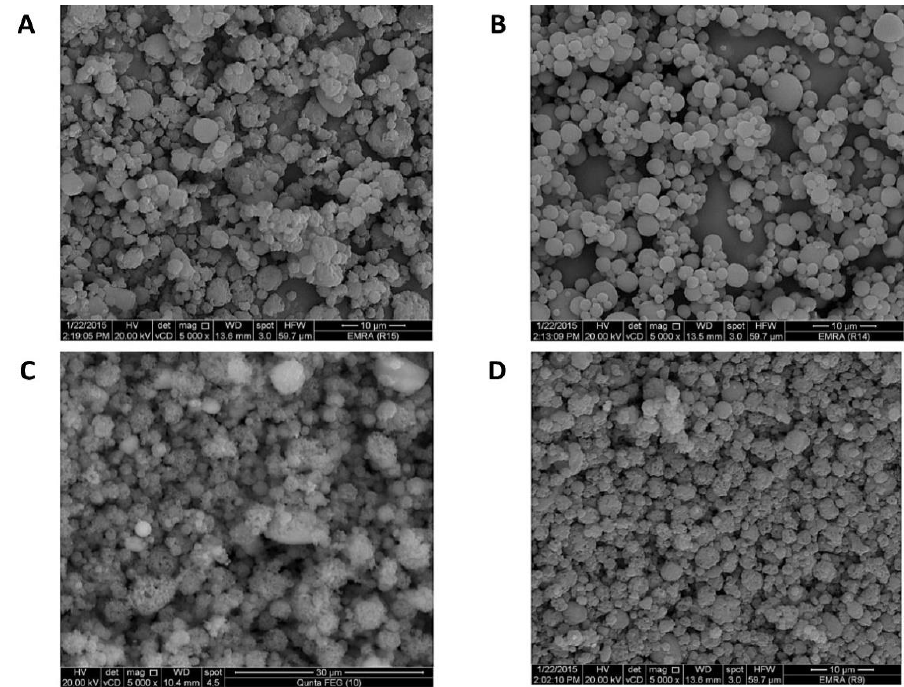
Figure 5. SEM micrographs of different TAA formulations. ( A ) 1% ( w/v ) TAA/ammonium